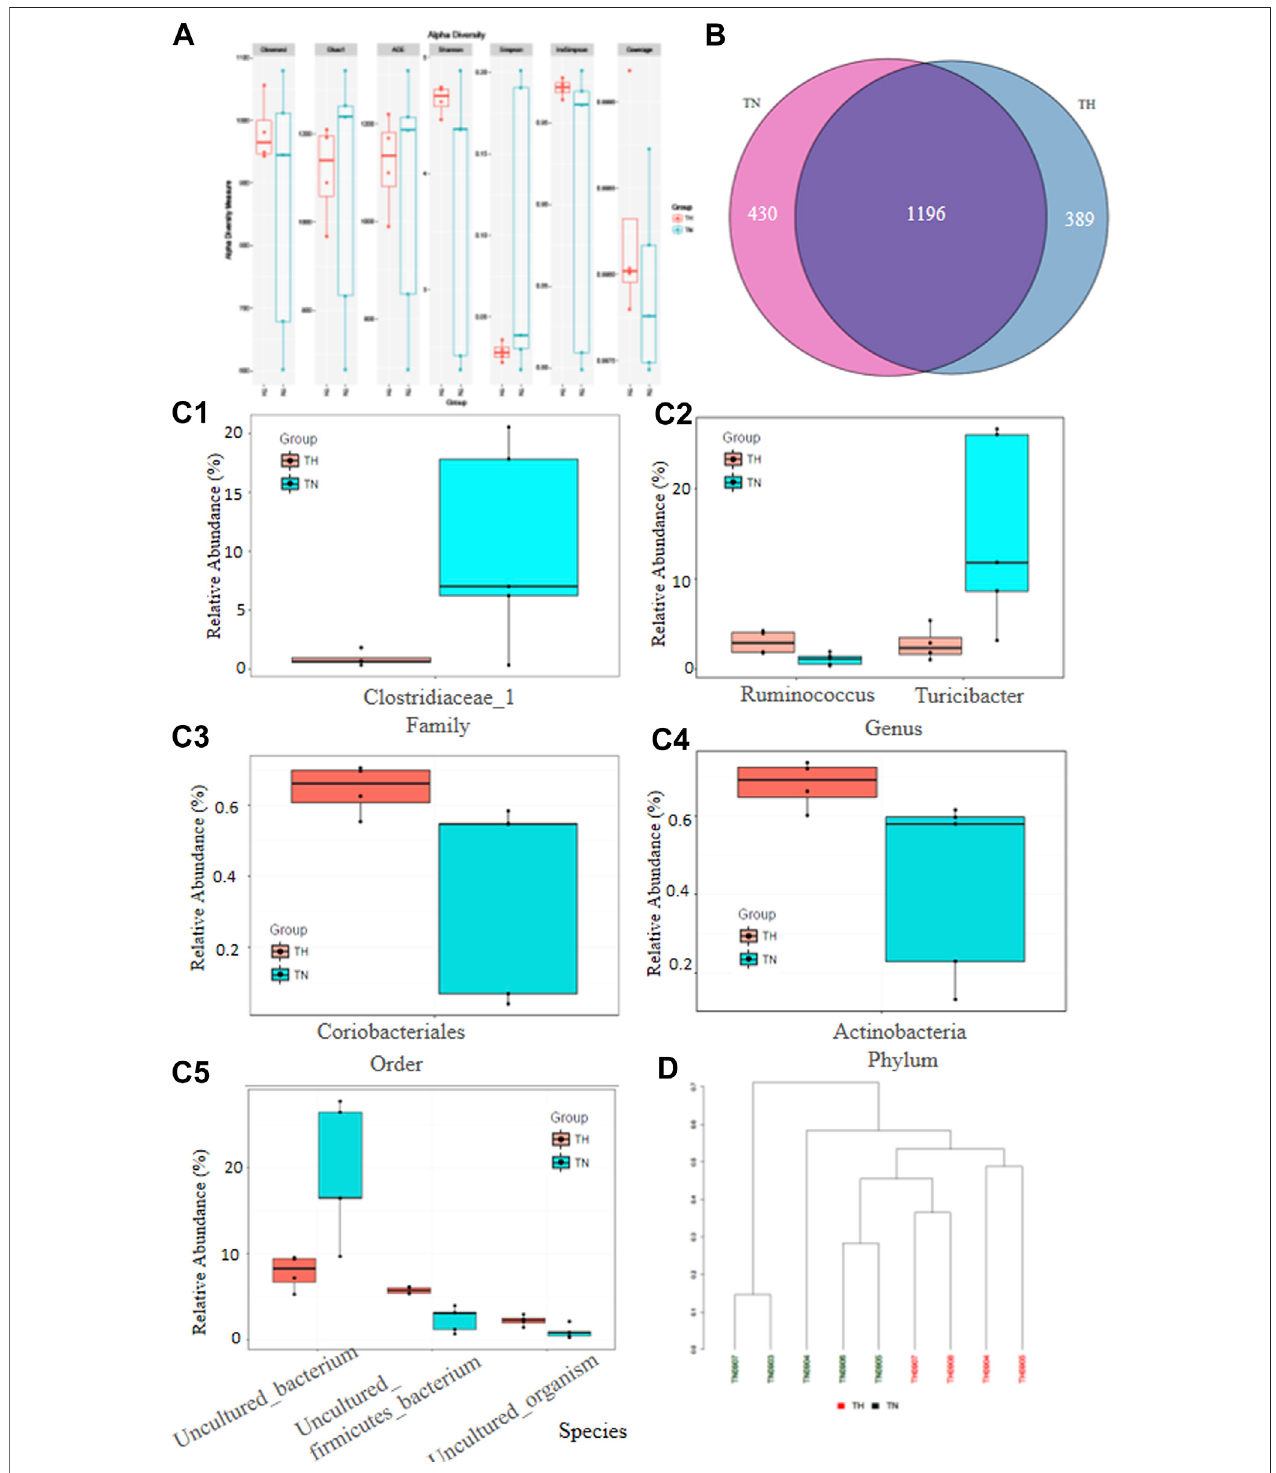
FIGURE 6 | Hydrogen alters the gut microbiota composition. (A) Whole-genome sequencing was performed for fecal samples from the TAA-pretreated rats followed with or without H 2 intervention and alphaDiversity between two groups was presented. (B) The average number of the gut microbiota in each group and the intersection number of the two groups. (C) The relative abundance of different taxonomic levels of bacterial strains in the two groups, including family (clostridiaceae_1) (C1), genus (ruminococcus and turicibacter), order (coriobacteriales) (C3), phylum (actinobacteria) (C4), and species (uncultured fi rmicutes_bacterium) (C5). (D) Cluster analysis of the nine rats treated with or without H 2 -rich water.